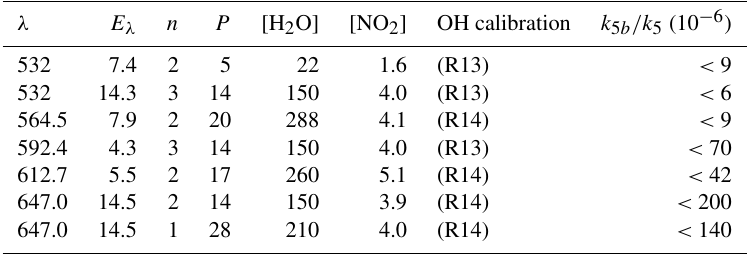
Table 1. Experimental conditions and results for NO ∗